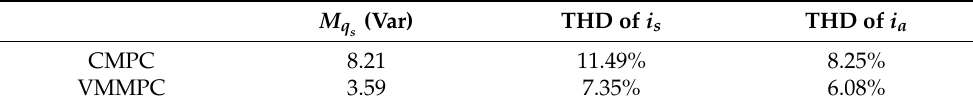
Table 4. The assessment parameters of experimental